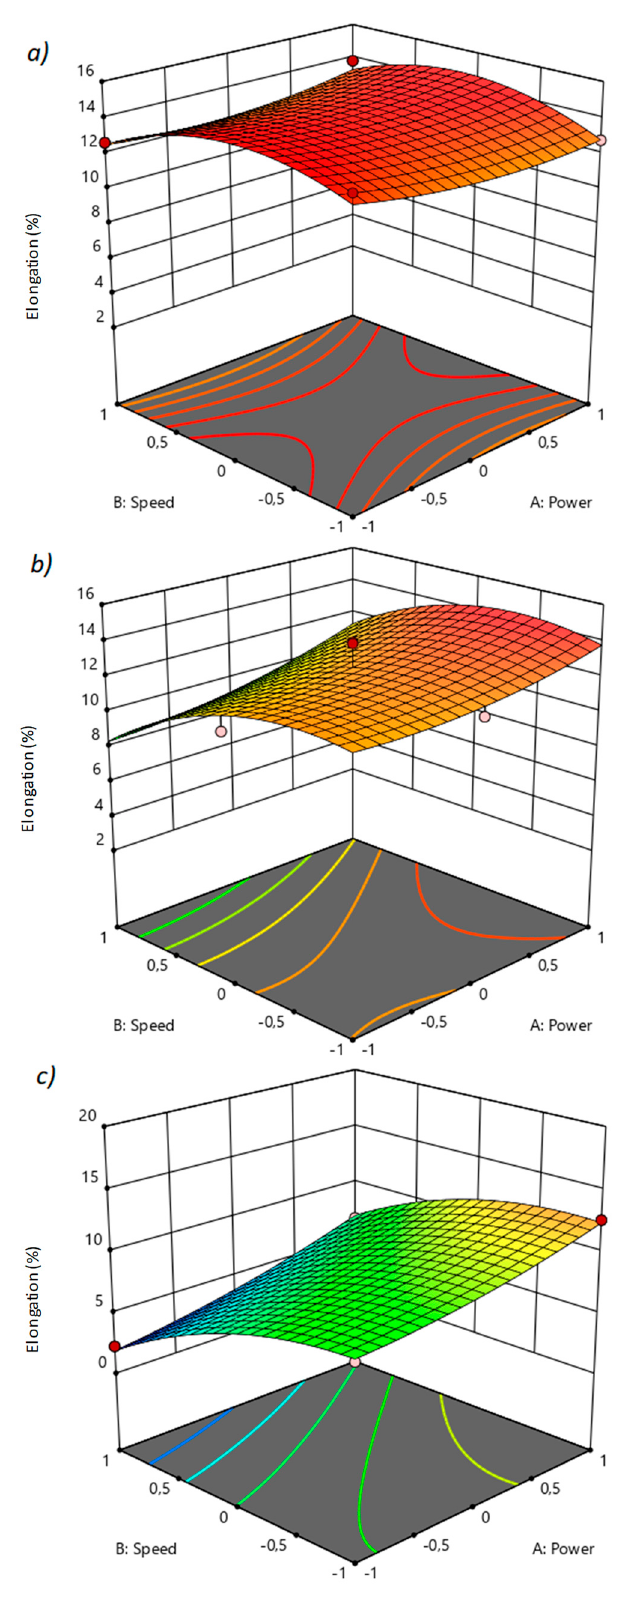
Figure 11. Response surfaces for ε r , ( a ) H ∗ = − 1 ( b ) H ∗ = 0 ( c ) H ∗ = 1 .